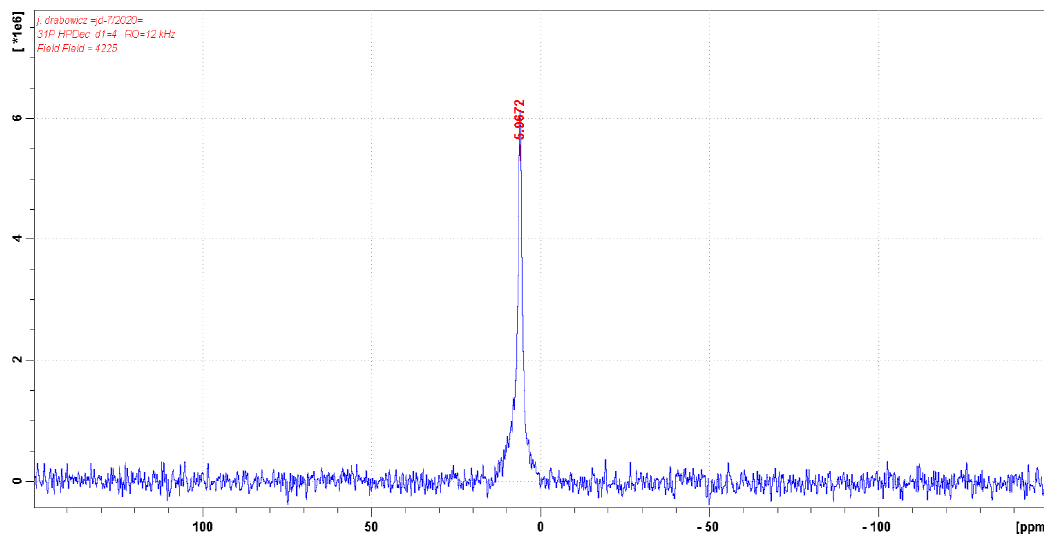
Figure 7. 31 P-NMR solid state spectrum of Cell- O -P(O)(OH)-H-48 sample.